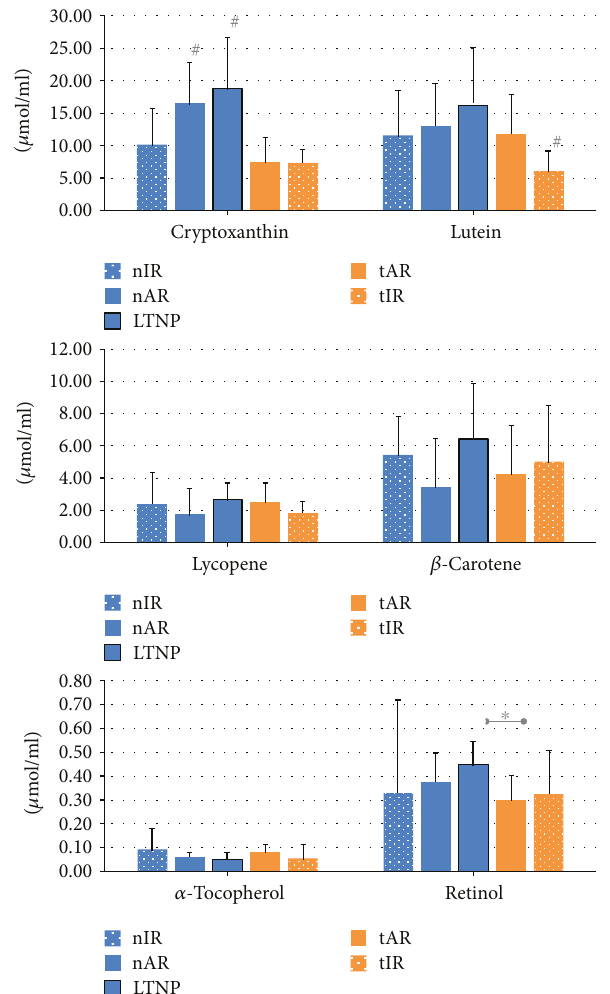
Figure 5: Plasma levels of carotenoids, retinol, and α -tocopherol of the 92 people living with HIV/AIDS, according to the fi ve study groups. LTNP presented higher cryptoxanthin and retinol in relation to cART groups. Statistical tests: gamma distribution. ∗ p < 0 05 , comparing the indicated groups; # p < 0 05 , di ff erence among all the other